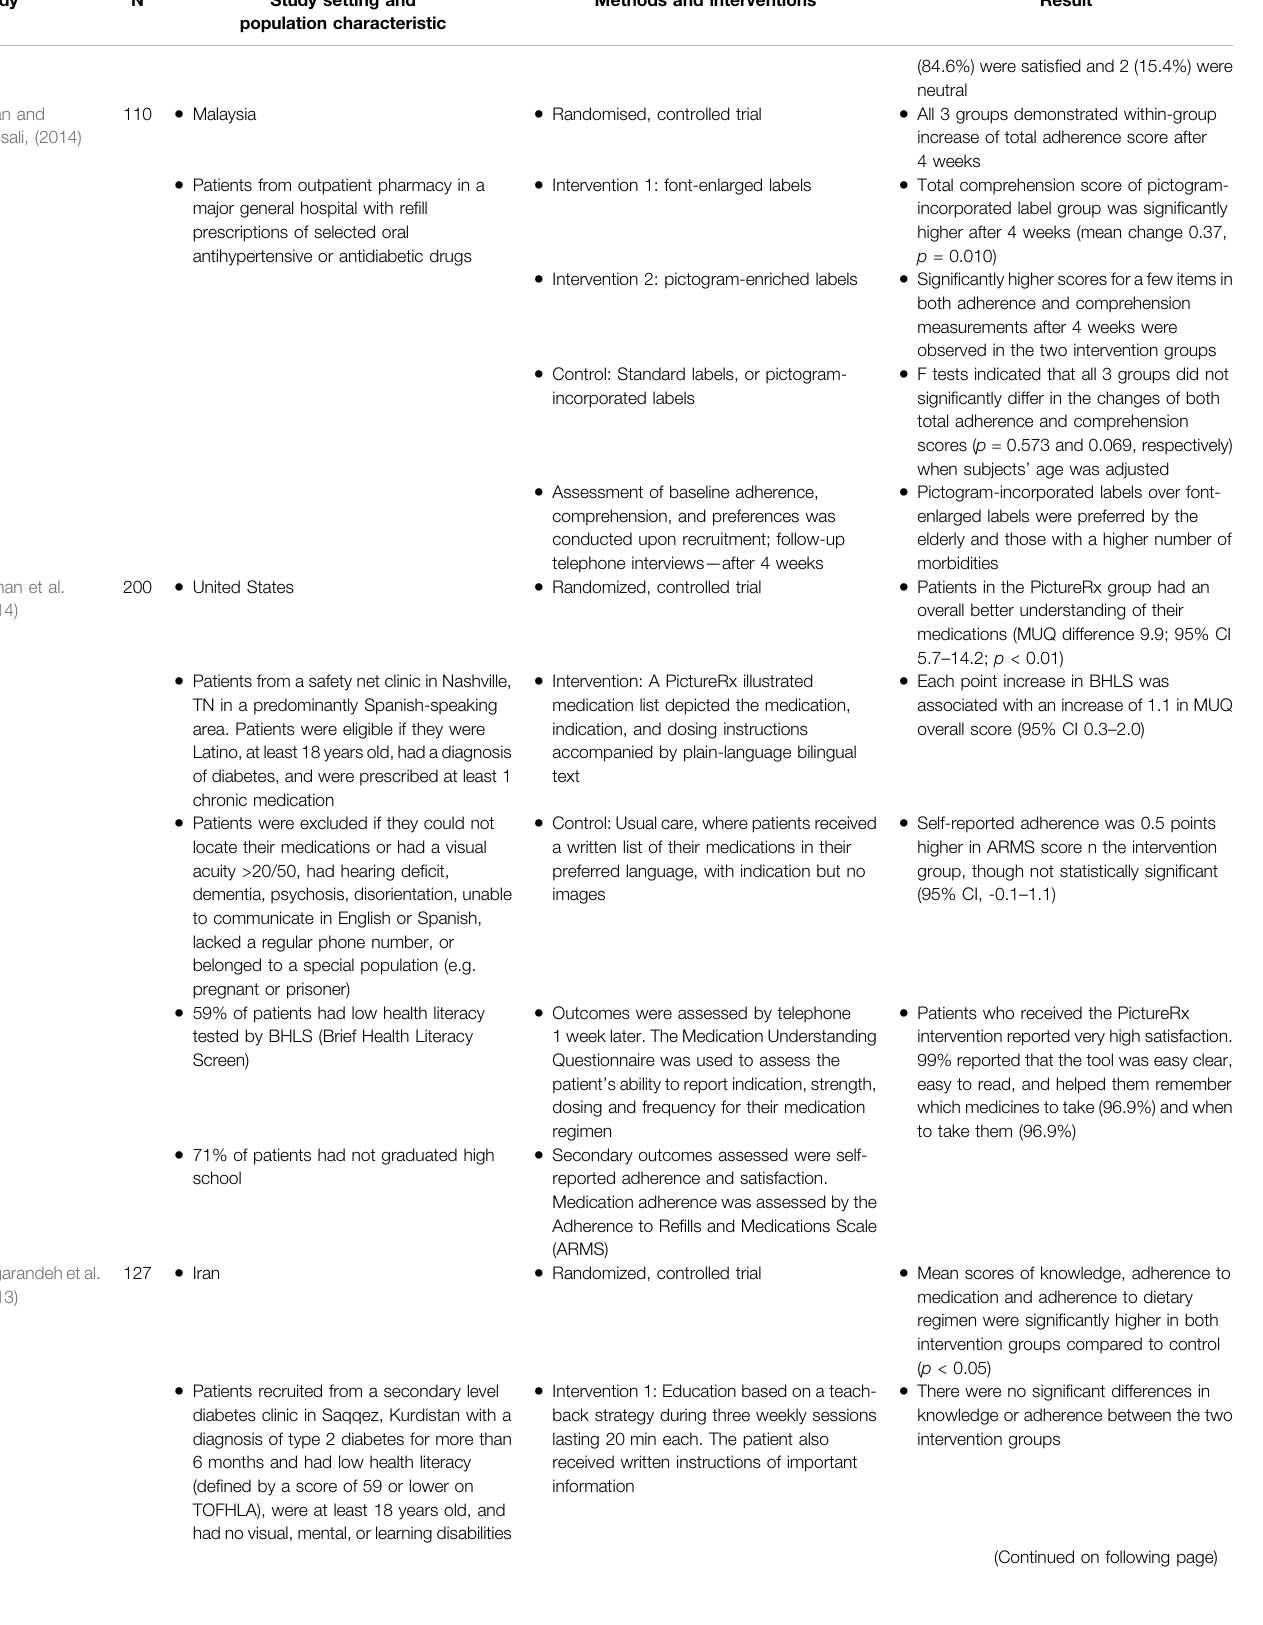
TABLE 1 | ( Continued ) Pictograms in the pharmaceutical care of chronically ill